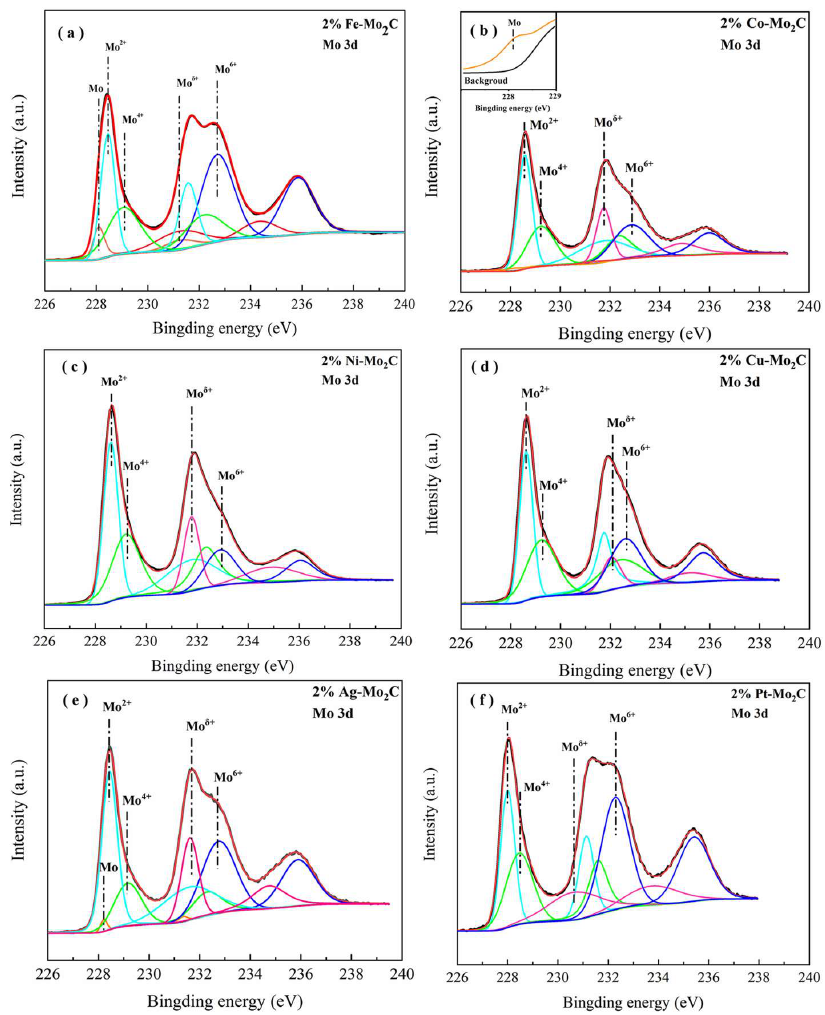
Figure 2. XPS spectra of ( a ) 2% Fe-Mo 2 C, ( b ) 2% Co-Mo 2 C, ( c ) 2% Ni-Mo 2 C, ( d ) 2% Cu-Mo 2 C, ( e ) 2% Ag-Mo 2 C and ( f ) 2% Pt-Mo 2 C.